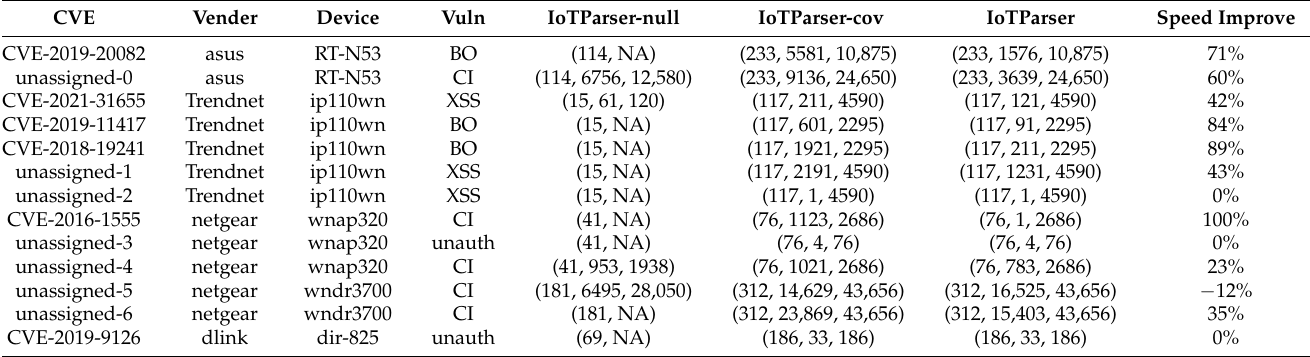
Table 3. Experimental results of IoTParser-null, IoTParser-cov and IoTParser. Each experimental result is represented by a triple (a, b, c), a: the number of initial seeds; b: the serial number of